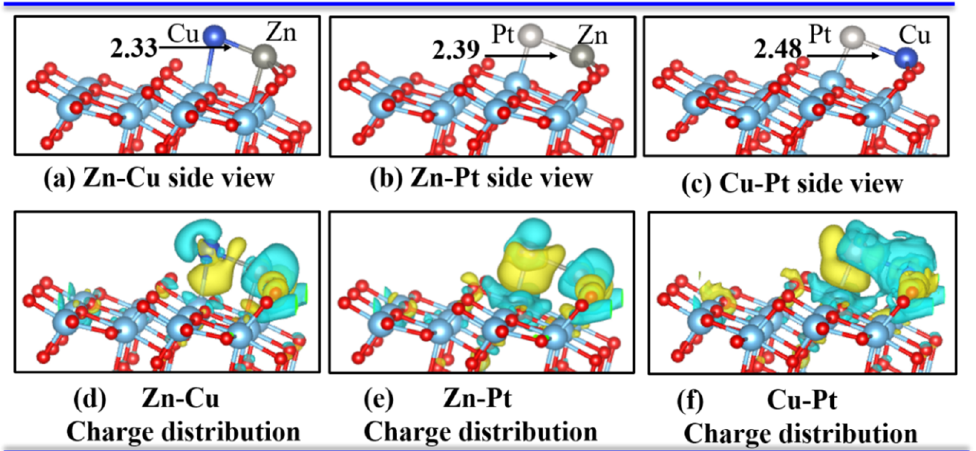
Figure 1. ( a – c ) Bimetallic ‐ dimer interstitial configurations. ( d – f ) Charge density induced by Zn ‐ Cu, Zn ‐ Pt, and Cu ‐ Pt interstitials of the TiO 2 (101) surface from a side view, respectively. The isosurface